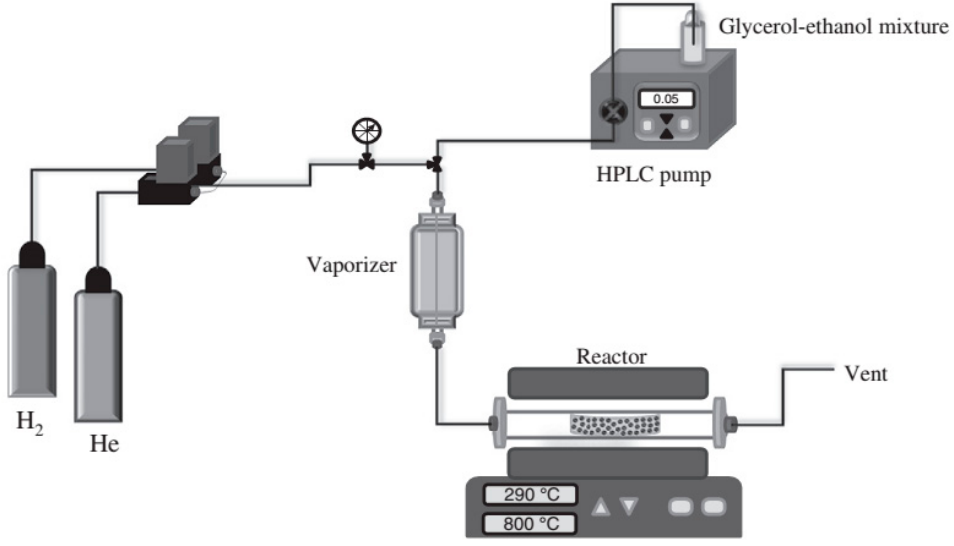
Figure 7. Sketch map of the chemical vapor deposition (CVD) (reprinted with permission from Ref. [60], copyright 2014 Elsevier).